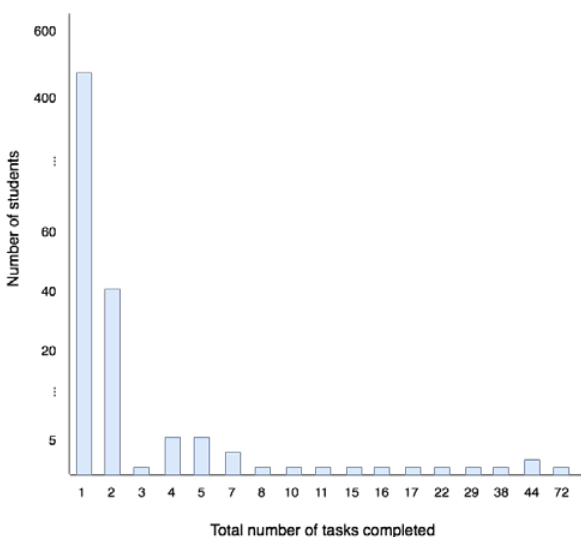
Figure 2. Overview of number of OSGeo tasks completed by